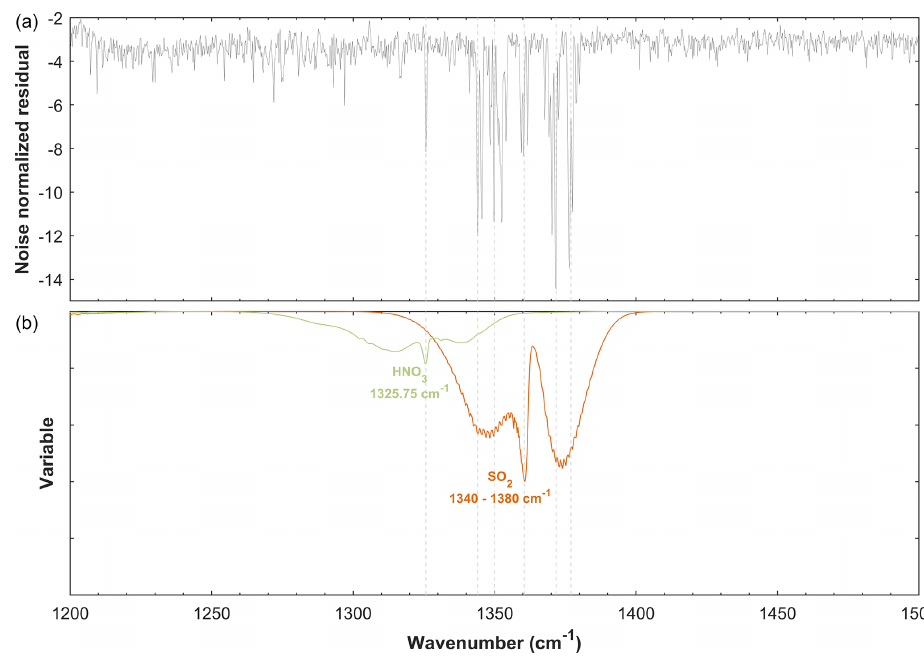
Figure 13. (a) Example of GMI pseudo-residual calculated from IASI/Metop-B L1C data during a sulfur plant fire event occurring in Iraq on 24 October 2016 in the evening (nighttime or PM orbit). (b) The HITRAN spectroscopic parameters associated with the absorption of different species (Gordon et al., 2017, 2022) are shown in colors.